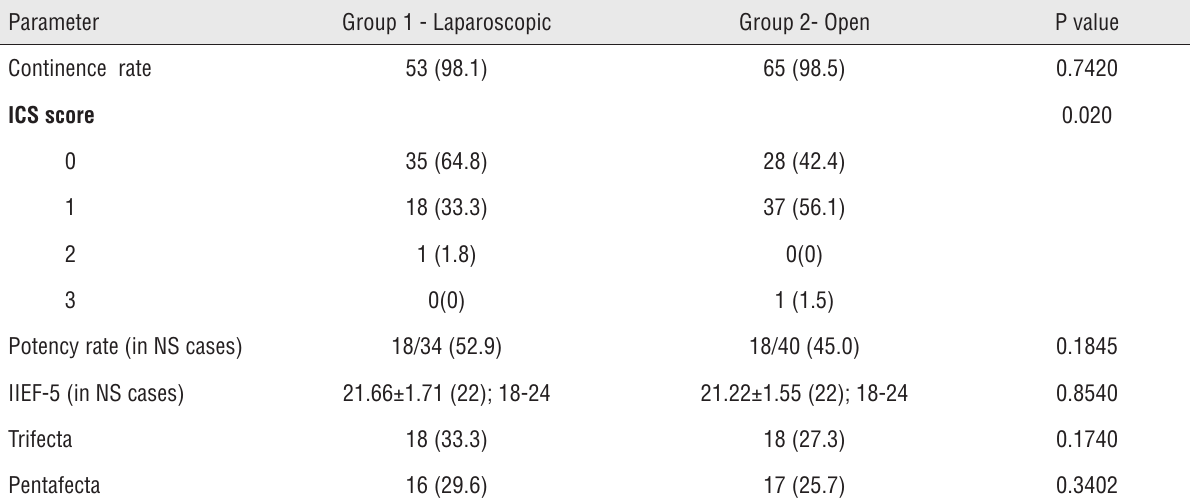
Table 7 - Comparison in functional outcomes and trifecta and pentafecta results at 12 months after surgery, between laparoscopic and open procedures. Results are presented as mean ± sD (mean) and range or number (%) of